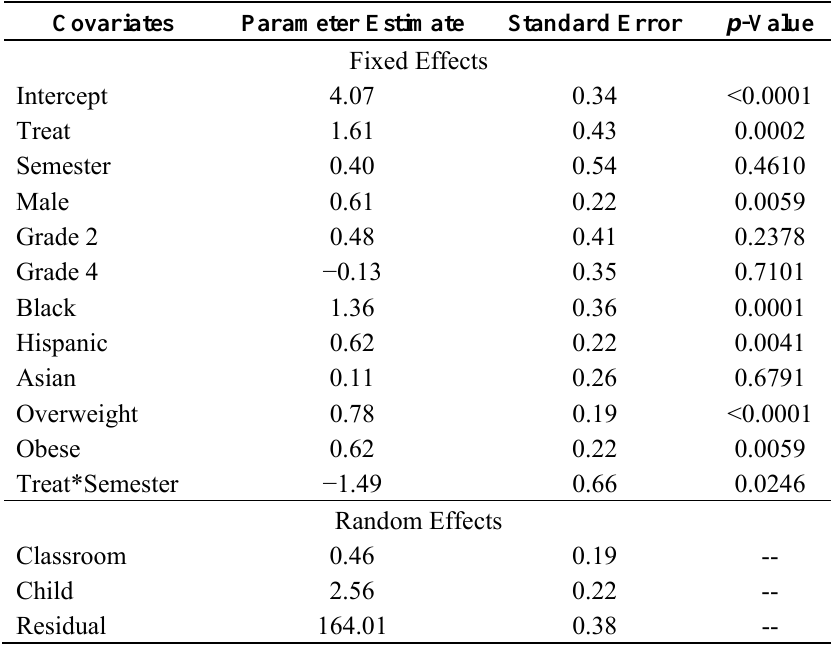
Table 5. Effects of treatment and other covariates on step counts from fitting a linear mixed effects model to the